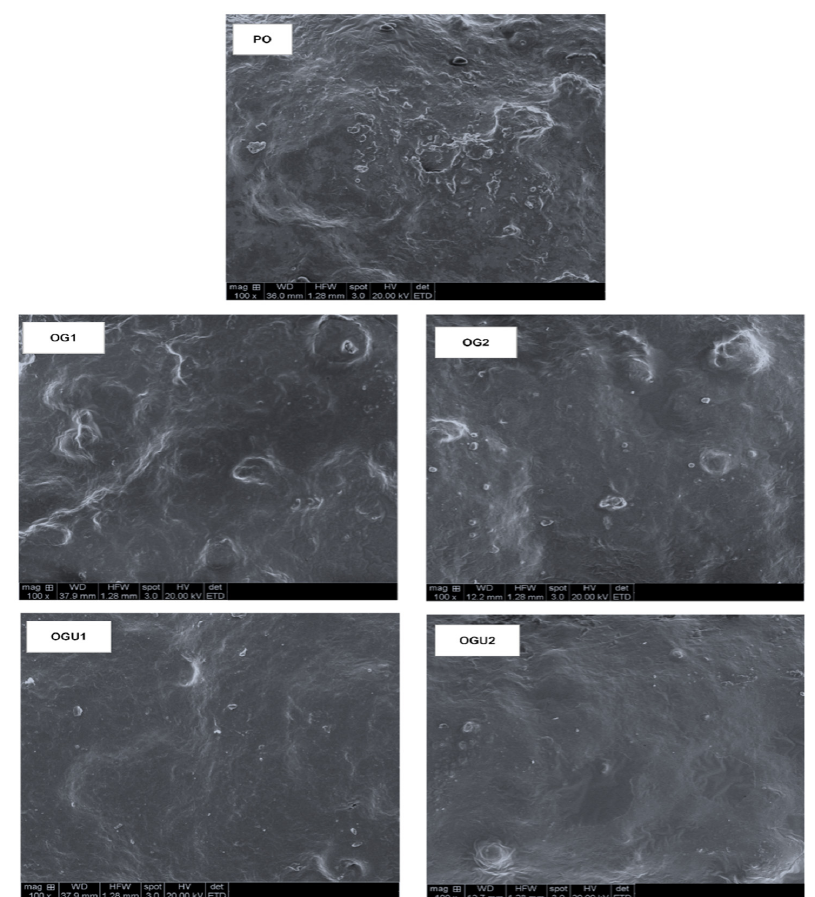
Figure 4. Microstructural observation of the surface of SDEW instant noodles that are fried using palm oil, palm oil–carnauba wax oleogel and palm oil–carnauba wax oleogel with ultrasonication treatments. Note: PO represents palm oil; OG1 represents palm oil–carnauba wax (5 g/100 g); OG2 represents palm oil–carnauba wax (10 g/100 g); OGU1 represents palm oil–carnauba wax (5 g/100 g) homogenized with ultrasonication; and OGU2 represents palm oil–carnauba wax (10 g/100 g) homogenized with